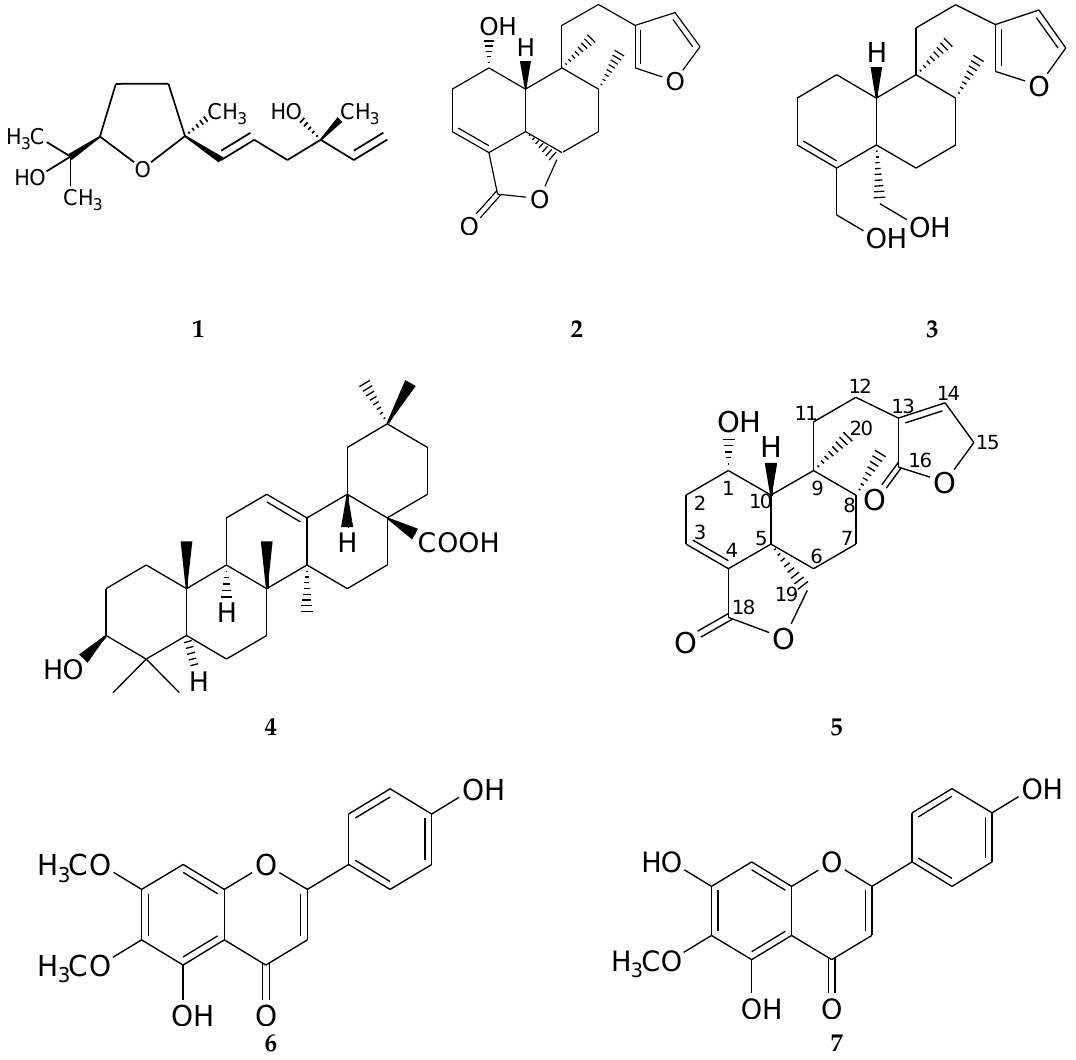
Figure 1. Chemical structure of compounds ( 1 – 7 ); schensianol A ( 1 ), bacchofertin ( 2 ), kingidiol ( 3 ), oleanolic acid ( 4 ), bacchofertone ( 5 ), cirsimaritin ( 6 ) and hispidulin ( 7 ) isolated of B. conferta . Compound 1 was obtained as a colorless oil with UV spectra (MEOH) λ max (log ε ) 207.7 nm. In